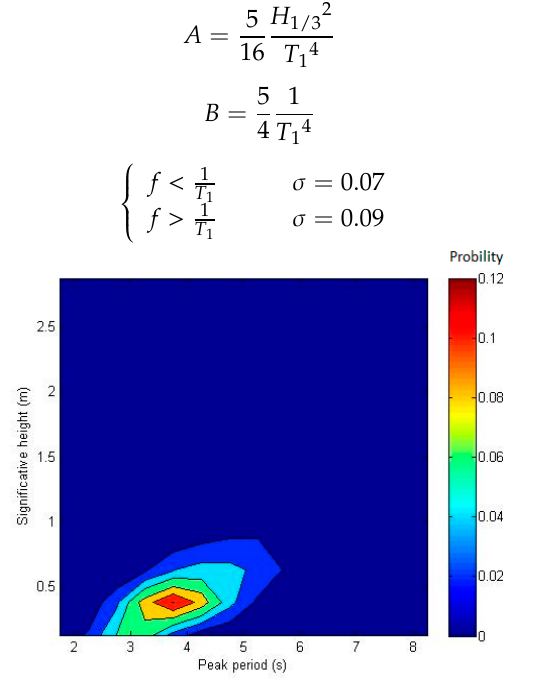
Figure 3. Wave characteristics and occurrence probability contour at Babolsar site.